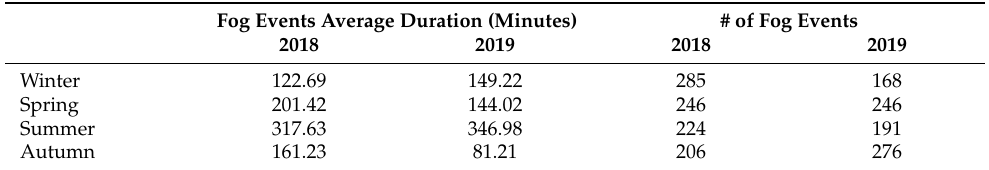
Table 4. Low-visibility events statistics at Mondoñedo station for years 2018 and 2019, and for the 2000 m threshold.